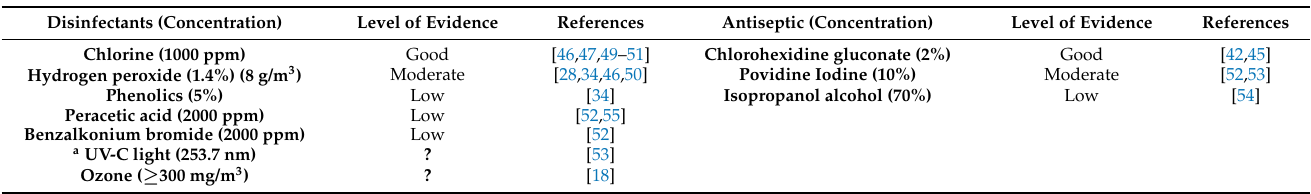
Table 1. Different disinfectants and antiseptic agents found effective against C. auris .